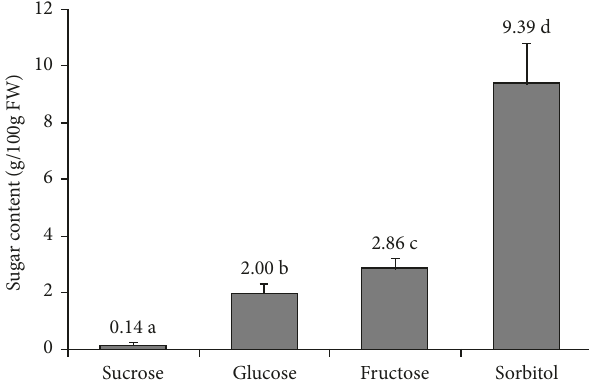
Figure 1: Average content (g/100g FW) of sugars in 23 samples of black chokeberry fruits. Results are presented as mean values from all samples ± SD. There are no significant differences among values marked with the same letters in individual